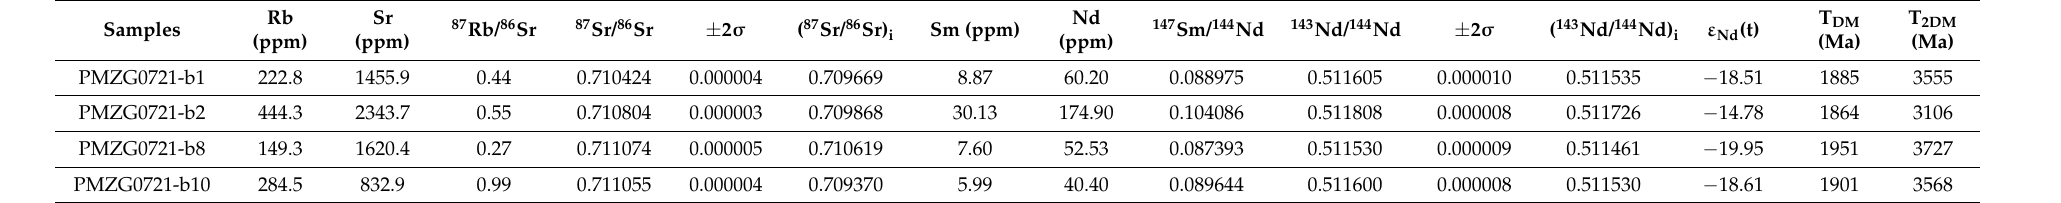
Table 6. Sr-Nd isotopic data of the Zhouguan granodiorite